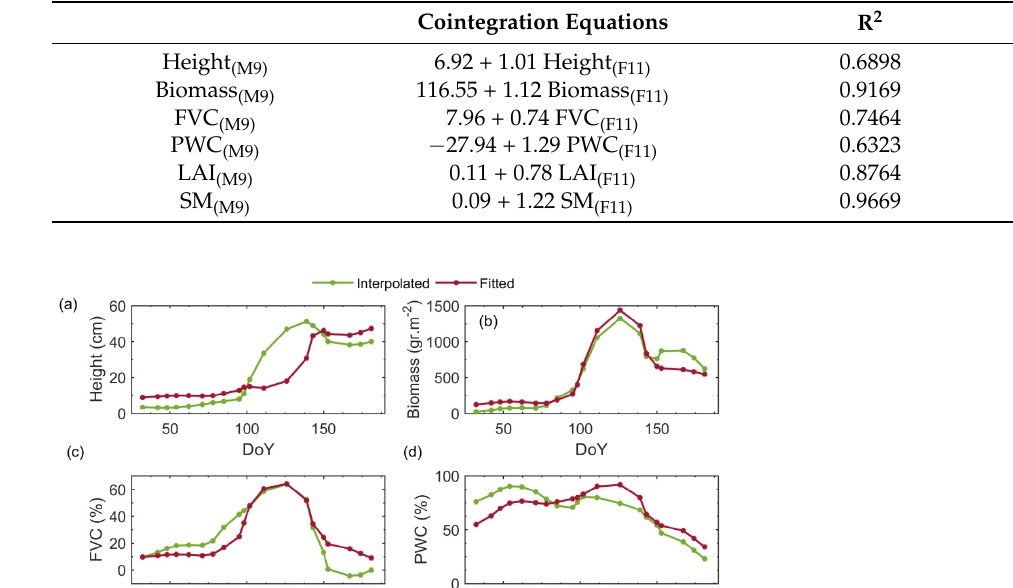
Table 8. Cointegration equations between the biophysical variables of F11 and M9 plots.